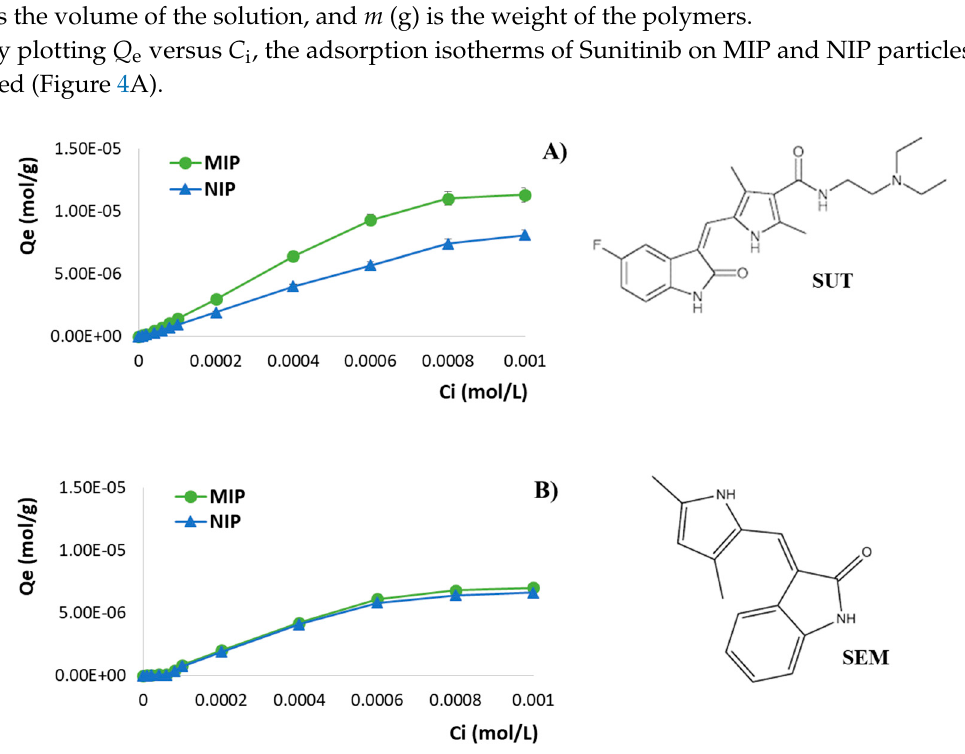
Table 2. Percentages of bound Sunitinib (SUT) and Semaxanib (SEM) by imprinted (MIP) and non- imprinted (NIP) particles and α and ε values for different C i . Data are shown as means ± S.D. Bound SUT (%) C i (mol/L)